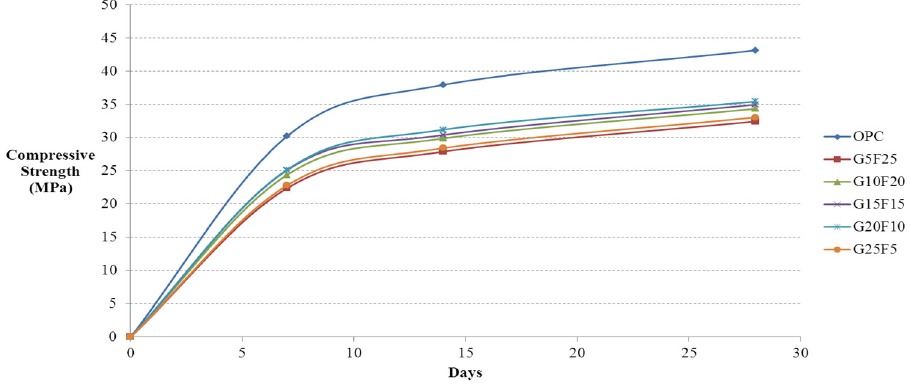
Figure 2. Compressive strength history of concrete with GGBS and flyash (W/B 43%).